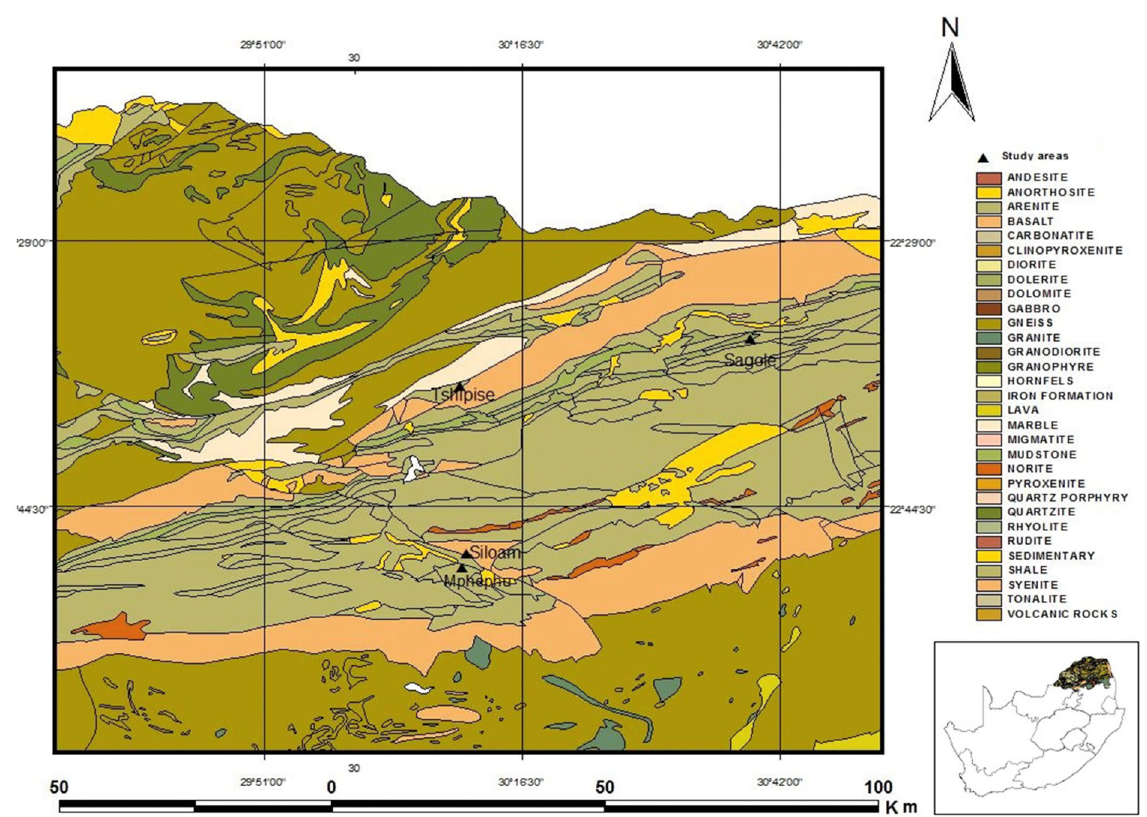
Figure 2. Geological map of the study area 32 , permission granted by Dr.